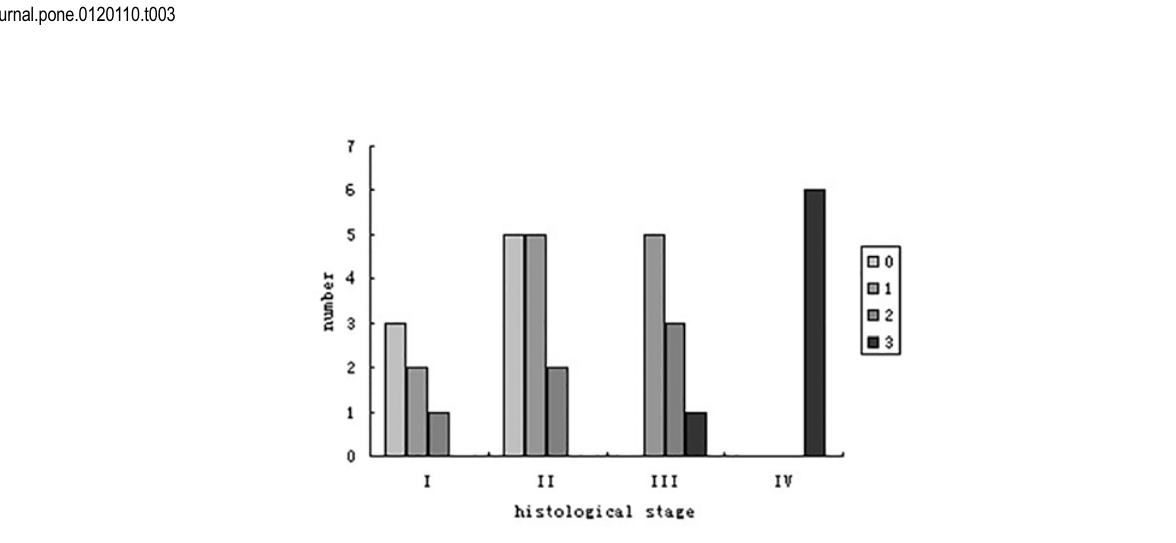
Fig 9. Liver signal grade at different histological stages.